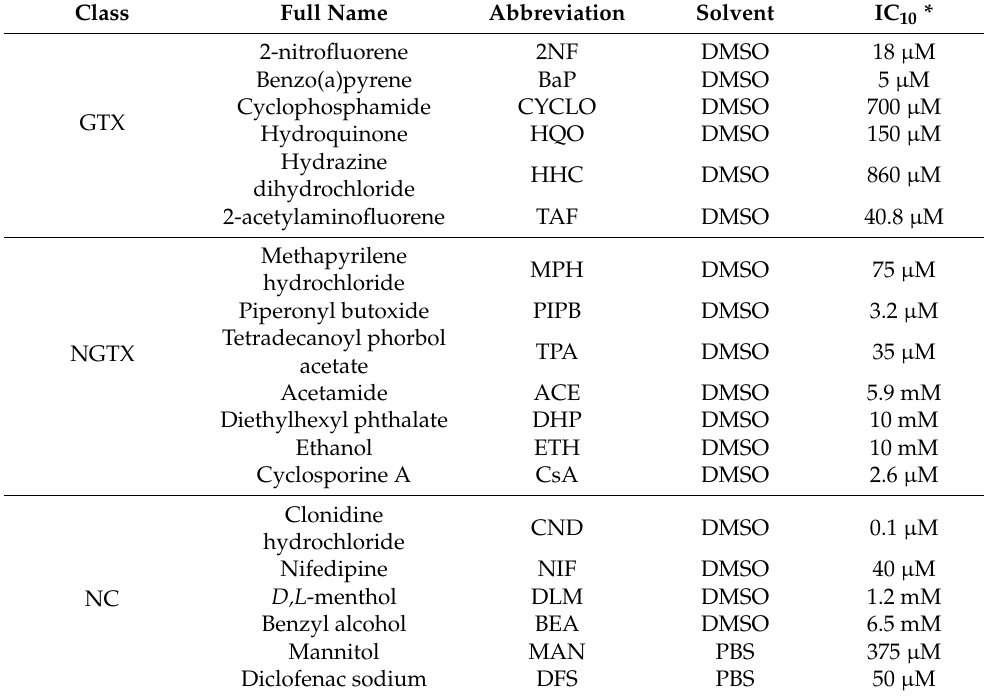
Table 1. Genotoxic carcinogenic (GTX) chemicals, non-genotoxic carcinogenic (NGTX) chemicals and non-carcinogenic (NC) chemicals. Class, full name, abbreviation, solvent (dimethyl sulfoxide (DMSO), or phosphate-buffered saline (PBS)) and IC 10 * concentration of the selected compounds are